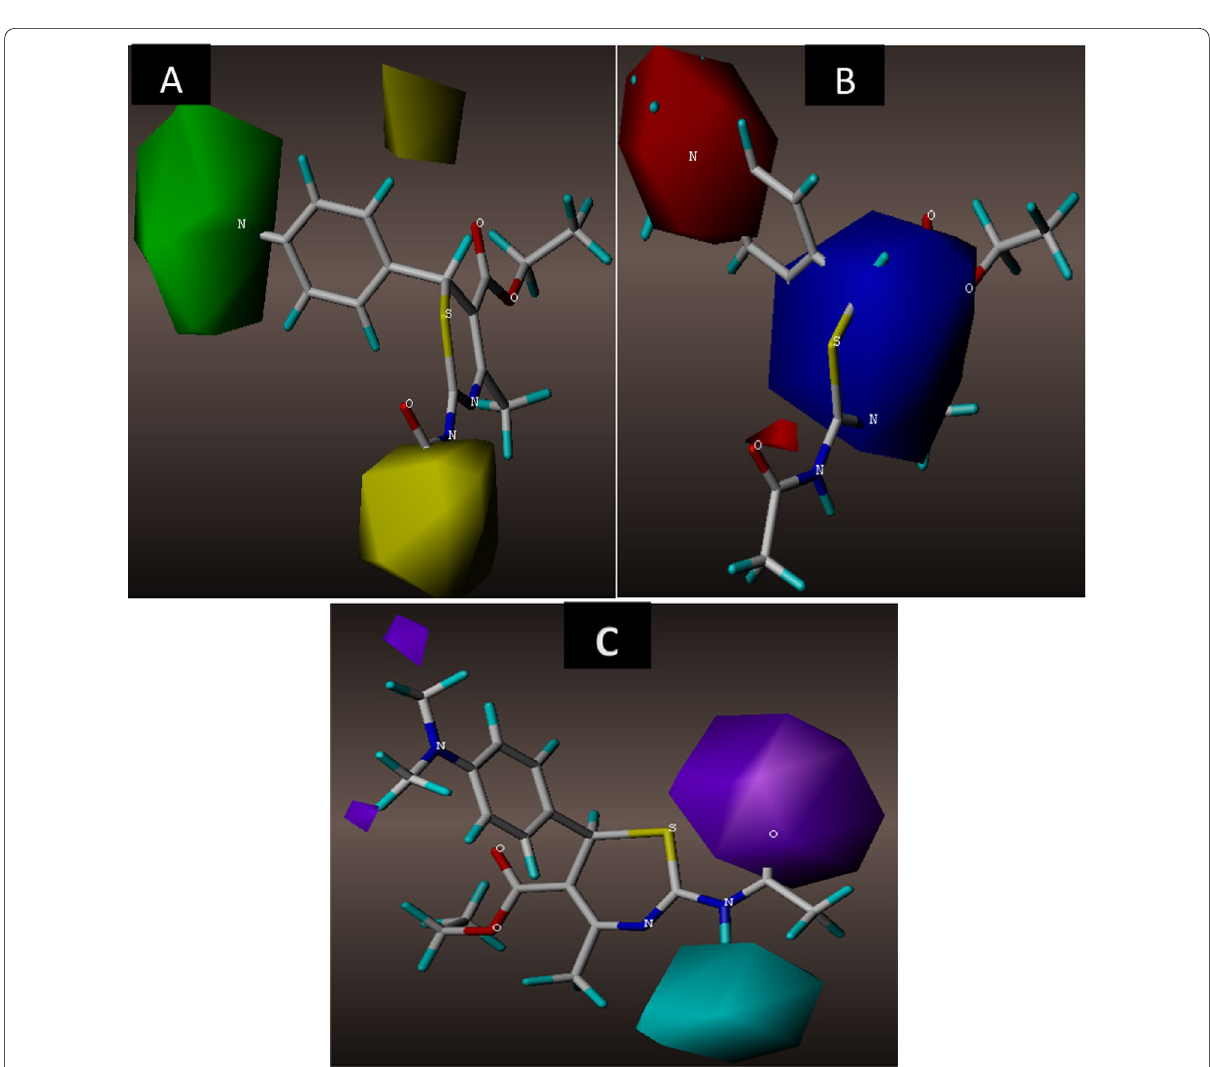
Fig. 8 3D fields contribution of the CoMSIA_EAD model for the most active compound 4. A Magenta contours represent regions for desirable hydrogen bond acceptors, while red areas represent undesirable acceptors, B electrostatic contour map where blue regions favor positive charge and red regions favors negative charge, C cyan contours represent areas for desirable hydrogen bond donors, while purple areas represent